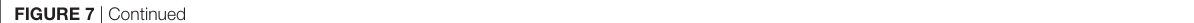
FiGURe 7 | Continued Regional myocardial blood flow (MBFs) and longitudinal MBF gradients in patients with multivessel CAD. Coronary flow parameters were assessed in the myocardial region with stress-related perfusion defect and with stenosis ≥ 50% (Region 1), without defect but with stenosis ≥ 50% (Region 2), or without stenosis ≥ 50% (Region 3). There was a mild and progressive increase in hyperemic MBFs and myocardial flow reserve (MFR) from region 1, region 2, to region 3. Further, the longitudinal MBF gradient during hyperemic flows was more pronounced in Region 2 than in Regions 1 and 3, respectively (A) . Of note, the longitudinal MBF gradient during hyperemic flows significantly correlated with the fractional flow reserve (FFR) ( r = 0.95, p < 0.0001), while this association was less pronounced for corresponding MFR ( r = 0.50, p = 0.006) (B) [adapted with kind permission of Valenta et al.